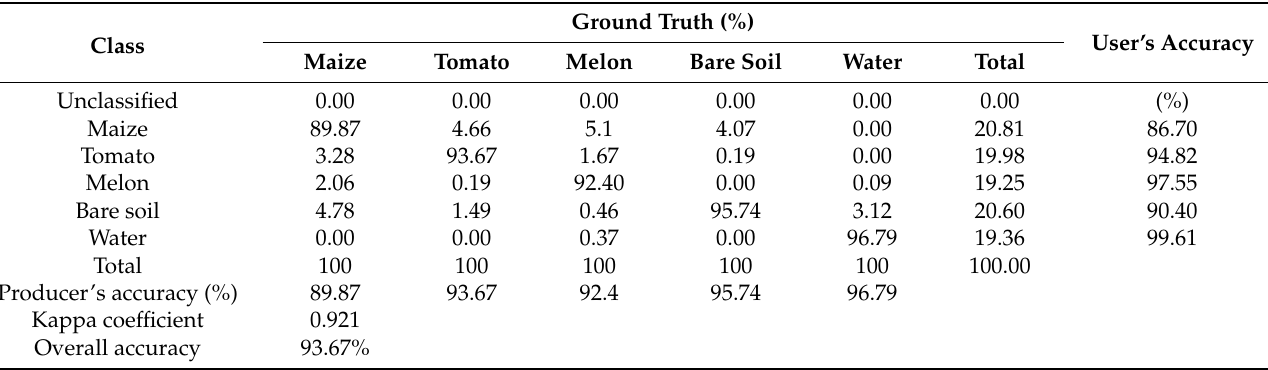
Table 4. Confusion matrix results for the MLC (Maximum Likelihood Classification) algorithm of maize and other crops in south-west Alexandria, Egypt.